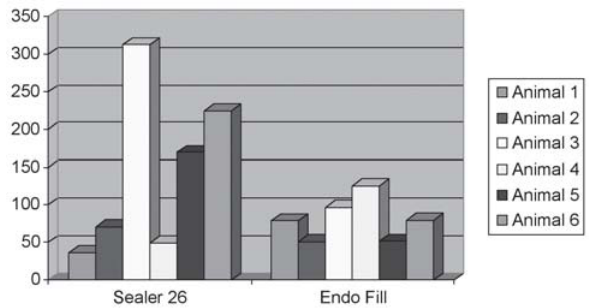
FIGURE 1 - Nitric oxide release in micromoles, by Cement Sealer 26 and Endofill, in a peritoneal macrophage culture from Swiss